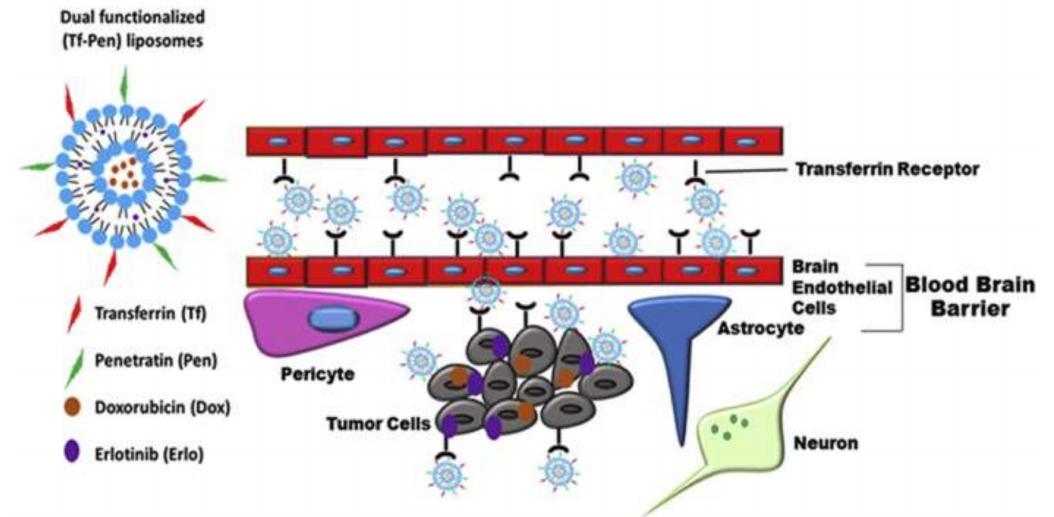
Figure 5. Schematic representation of dual-functionalized (Tf–Pen) liposomes translocation across the BBB, followed by endocytosis into glioblastoma cells. Reprinted with permission from Ref. [173], Copyright 2019,